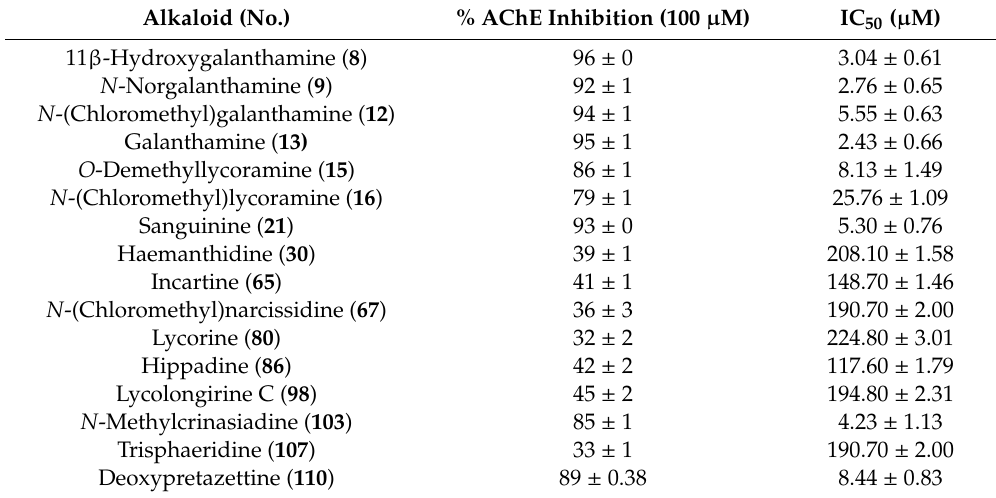
Table 3. AChE inhibitory activity of Amaryllidaceae alkaloids isolated from bulbs of L. longituba. [30]. Alkaloid